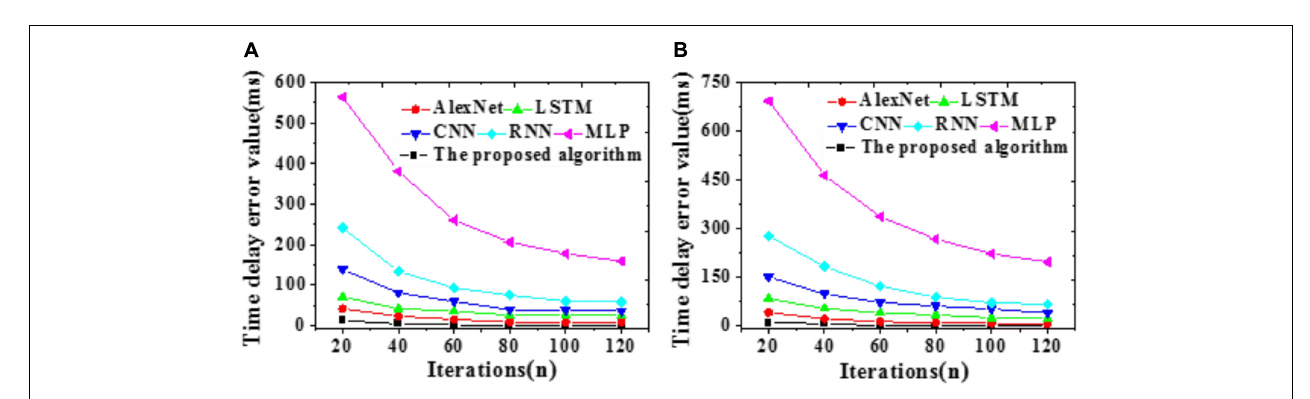
FIGURE 7 | Time duration required by different models (A) Training duration; (B) Test duration.